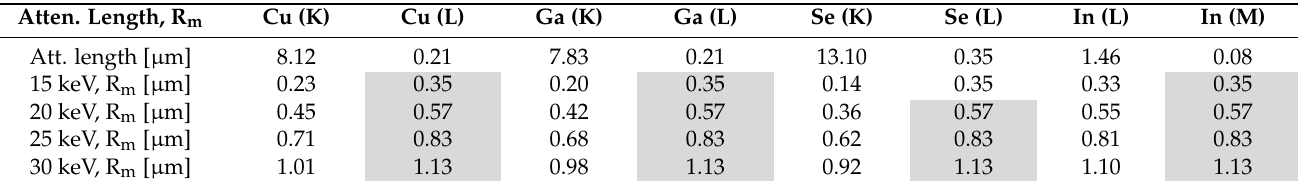
Table 3. Depth of maximum ionization R m and attenuation length for different X-ray lines in CIGSe.